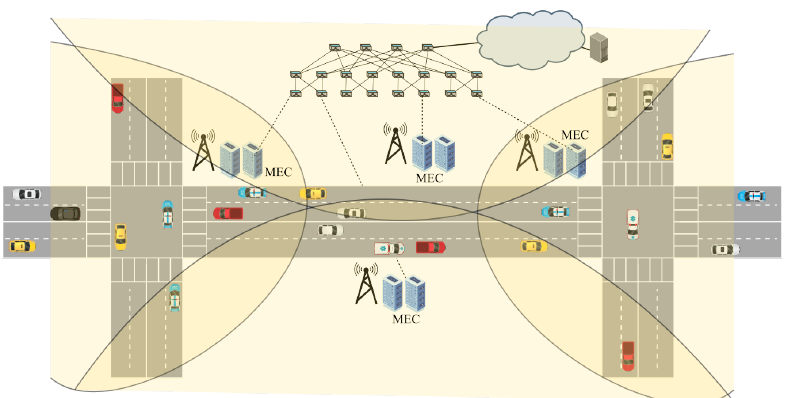
Figure 1. An example of a vehicular multi-access edge computing (MEC)